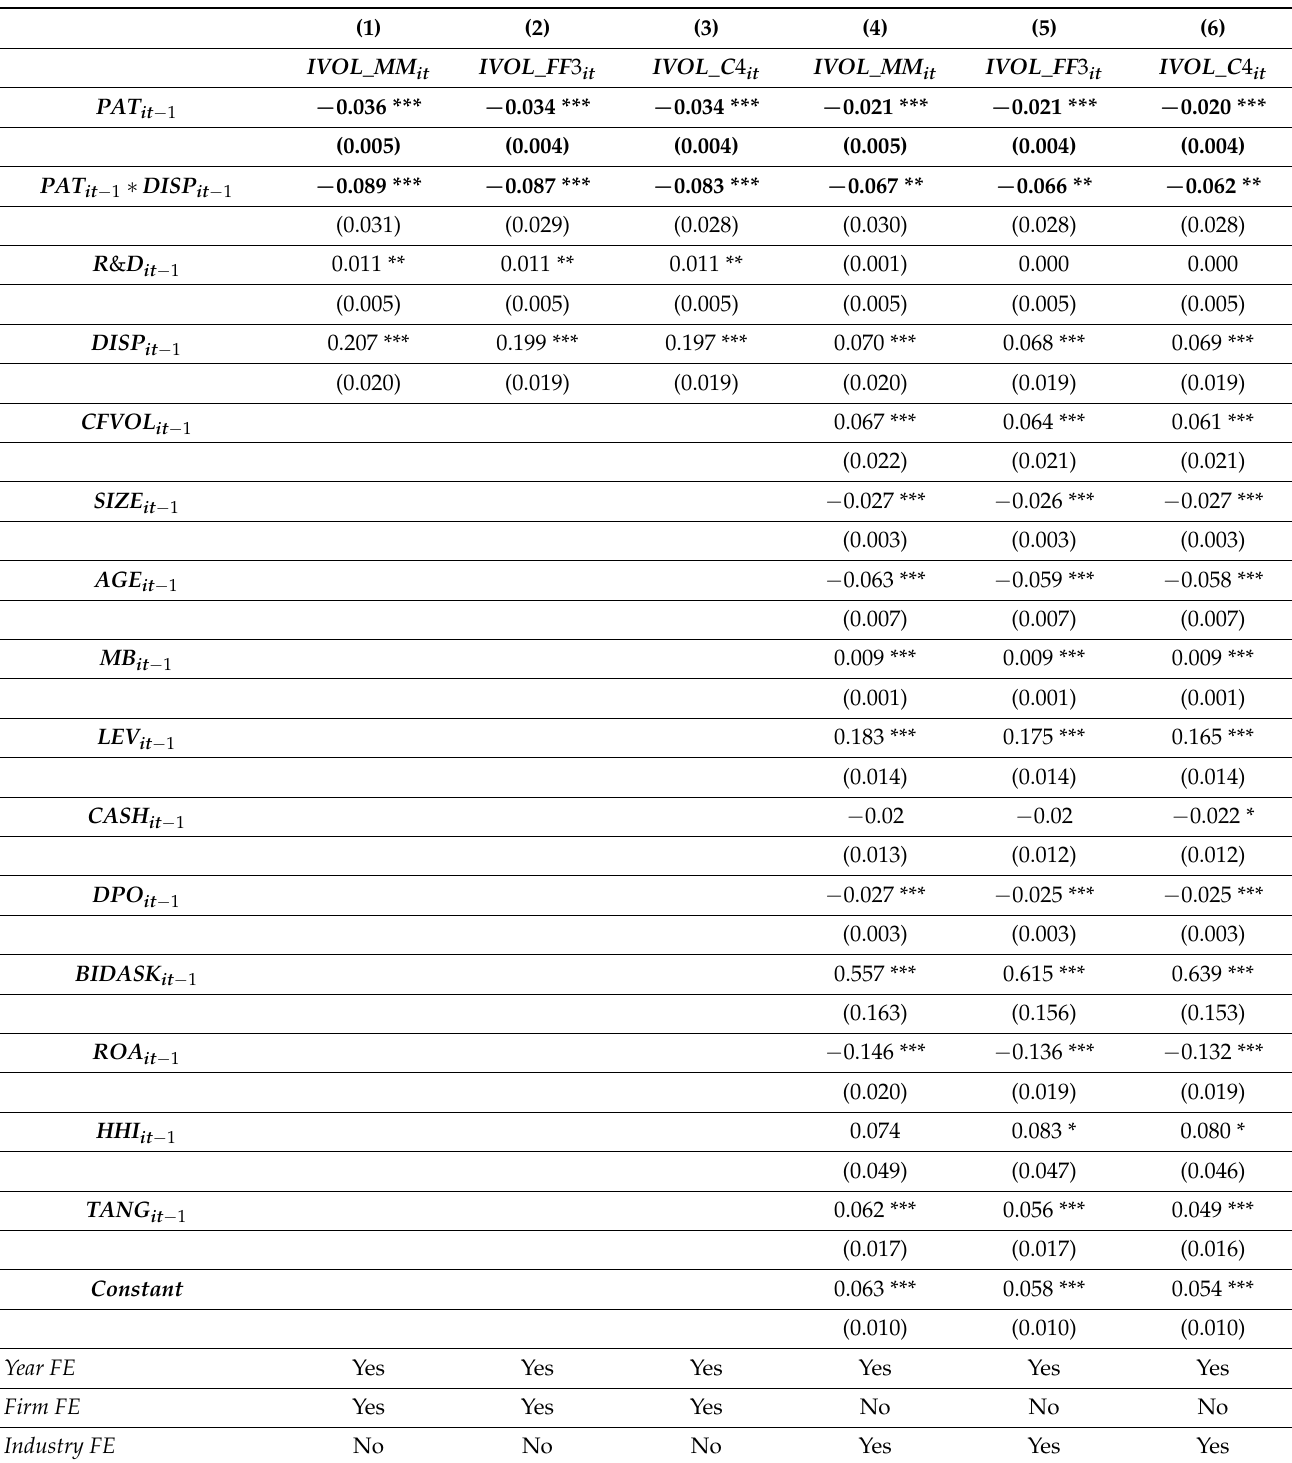
Table 7. The interaction between innovation, information uncertainty, and idiosyncratic volatility. This table shows the interaction between innovation and information uncertainty and their relation- ship’s effect on idiosyncratic volatility. The definitions of the variables are provided in Appendix A. Fixed effects are included. Standard errors clustered by firm and year are reported in parentheses. The sample period is from 1982 to 2015. ***, **, and * denote significance at the 1, 5, and 10% level,